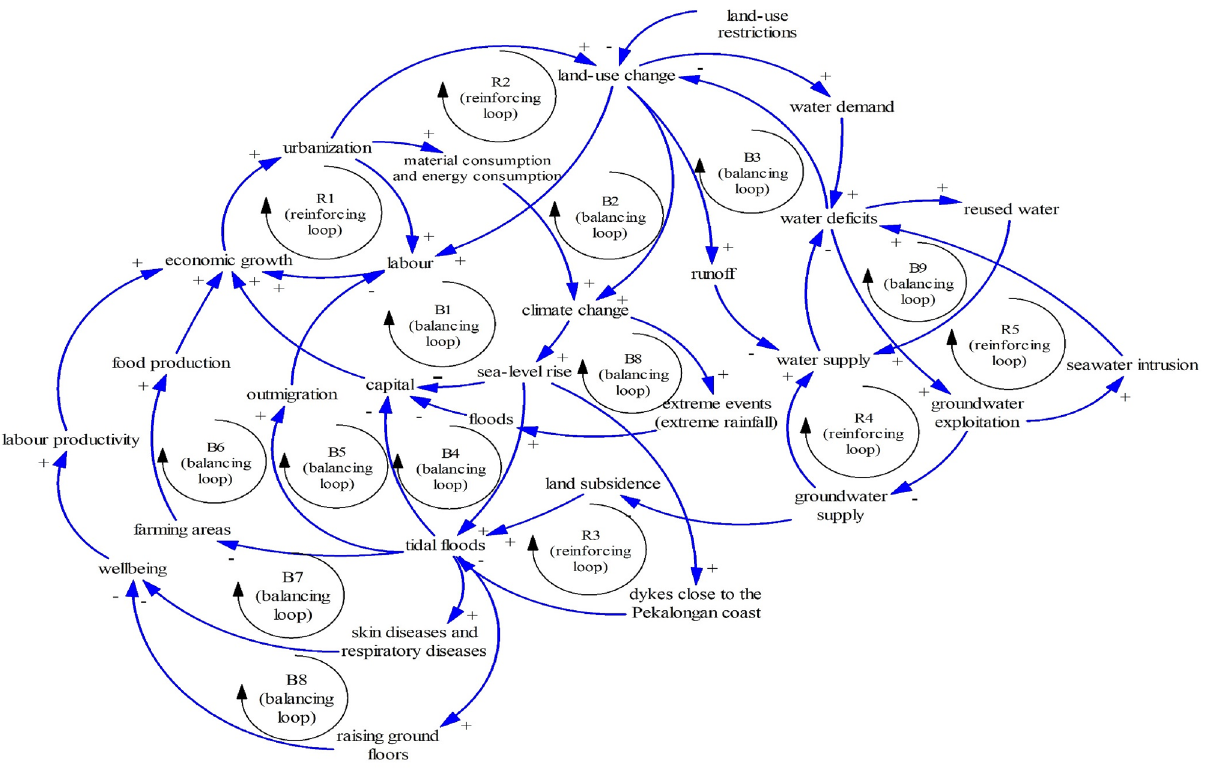
Figure 16. A causal loop diagram.